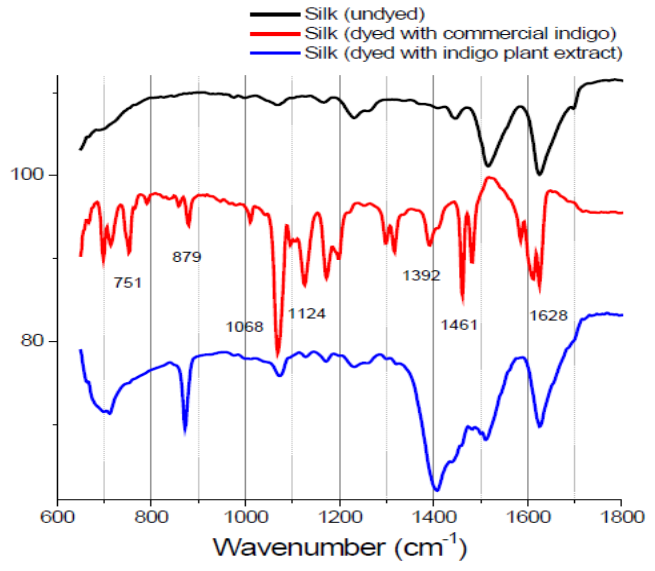
Figure 2. Fourier transform infrared spectra of undyed silk textile with commercial indigo and silk textile dyed with indigo plant extract. The characteristic peaks allow easy identification. The spectra are vertically shifted for sake of